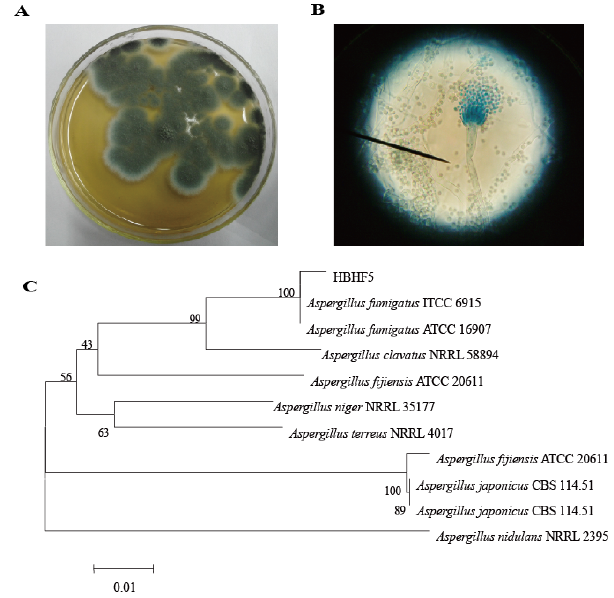
Figure 1. Identification of isolated A. fumigatus HBHF5 strain. ( A ) Strain HBHF5 cultivated on PDA plate at 45 °C. ( B ) Morphology of strain HBHF5 stained with lactophenol cotton blue. ( C ) Phylogenetic tree analysis of strain HBHF5.